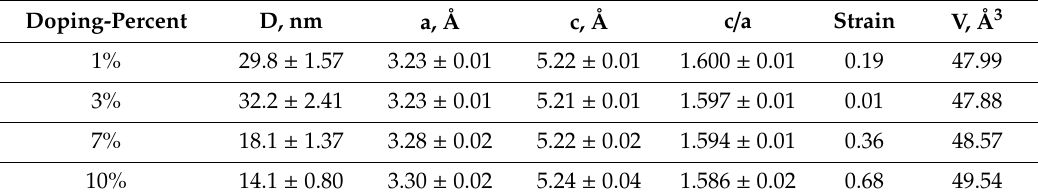
Table 1. Summary of structural properties present in the assorted samples ZnNiO powders calculated by XRD data fitting. Columns from left represent Ni content (weight percentage), average crystallite size (D) in nanometers (nm), lattice constants (a, c) and their ratio (c / a), bulk strain ( ∆ d / d) present in ZnNiO nanoparticles and their unit cell volume